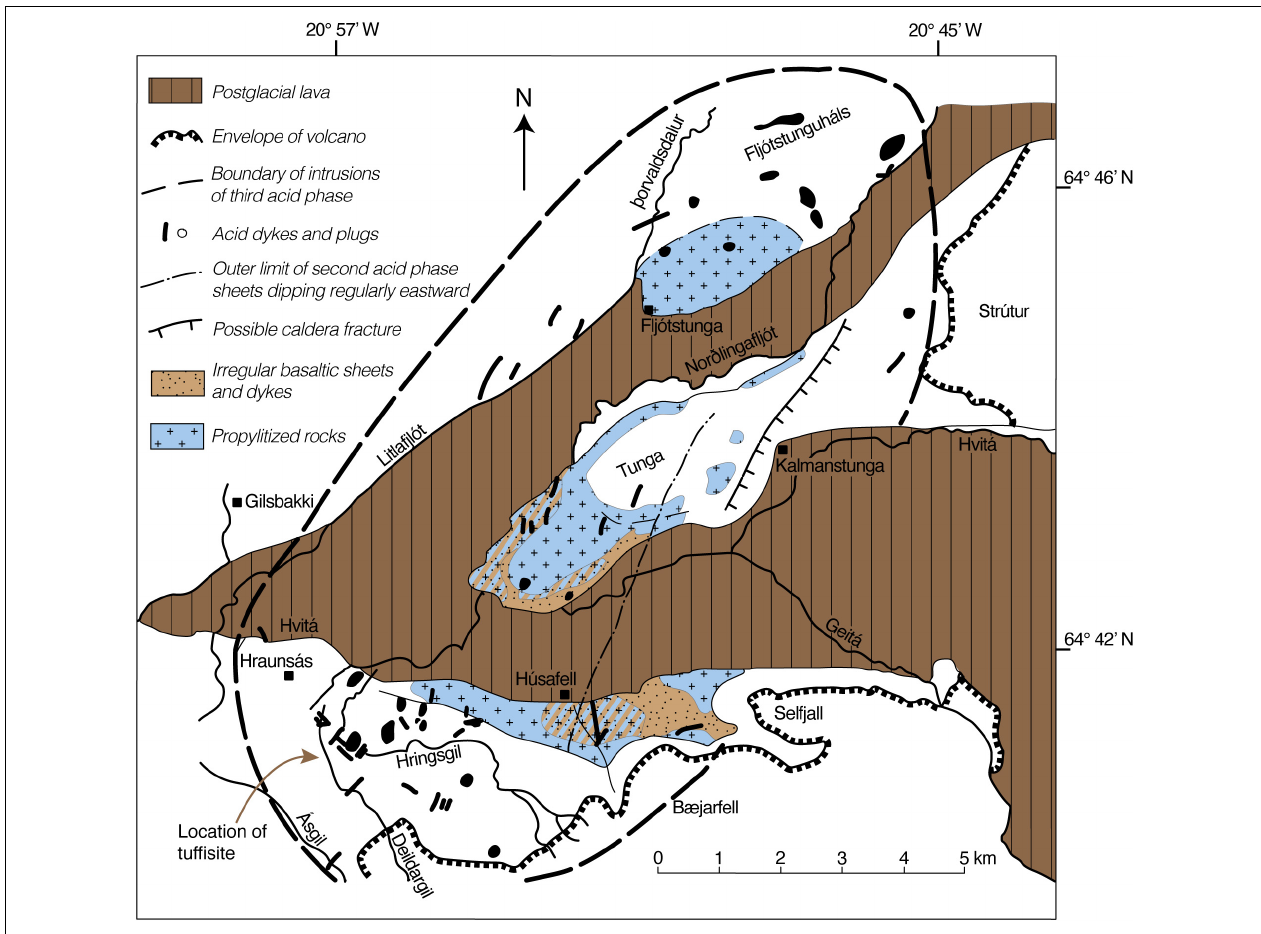
FIGURE 2 | Map of the geology of the Húsafell area with the location of the tuffisite, in Deildargil. Adapted from Sæmundsson and Noll (1974)